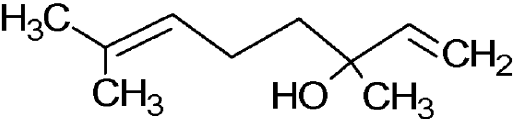
Figure 1. Structure of